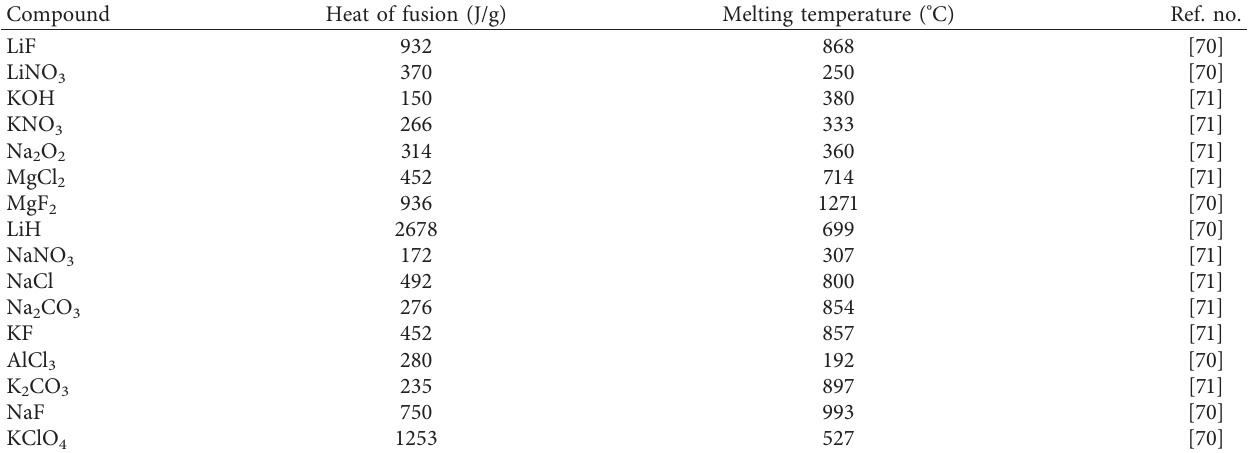
Table 2: Inorganic compound which can be used as a PCM.